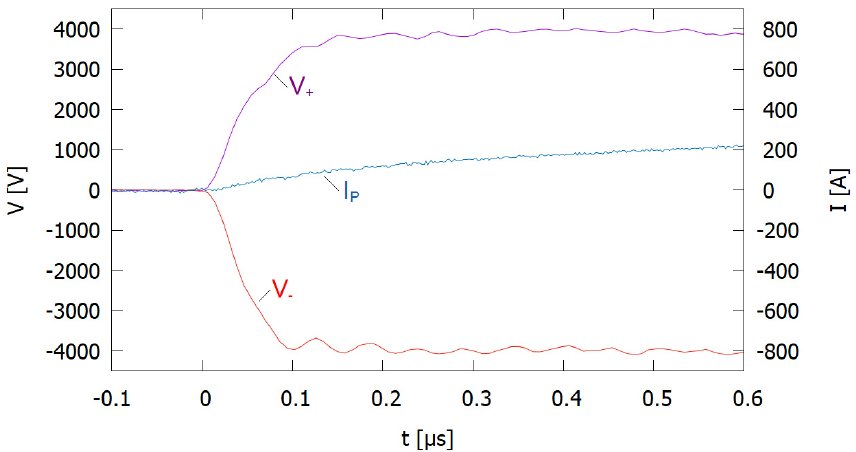
Figure 26. Measured rise of the pulse voltage at the positive (V + ) and negative (V - ) output terminal of an 8-stage Marx generator in ground-symmetric operation and the pulse current I P